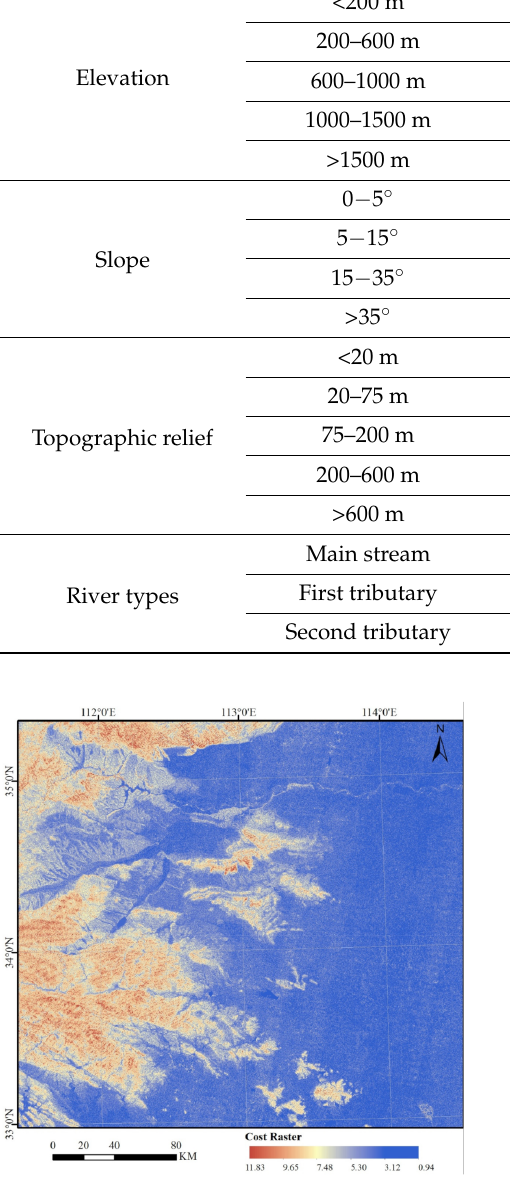
Figure 3. Cost raster